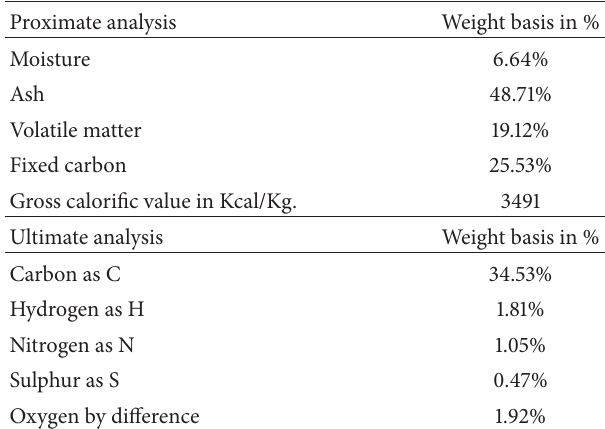
Table 1: Coal analysis